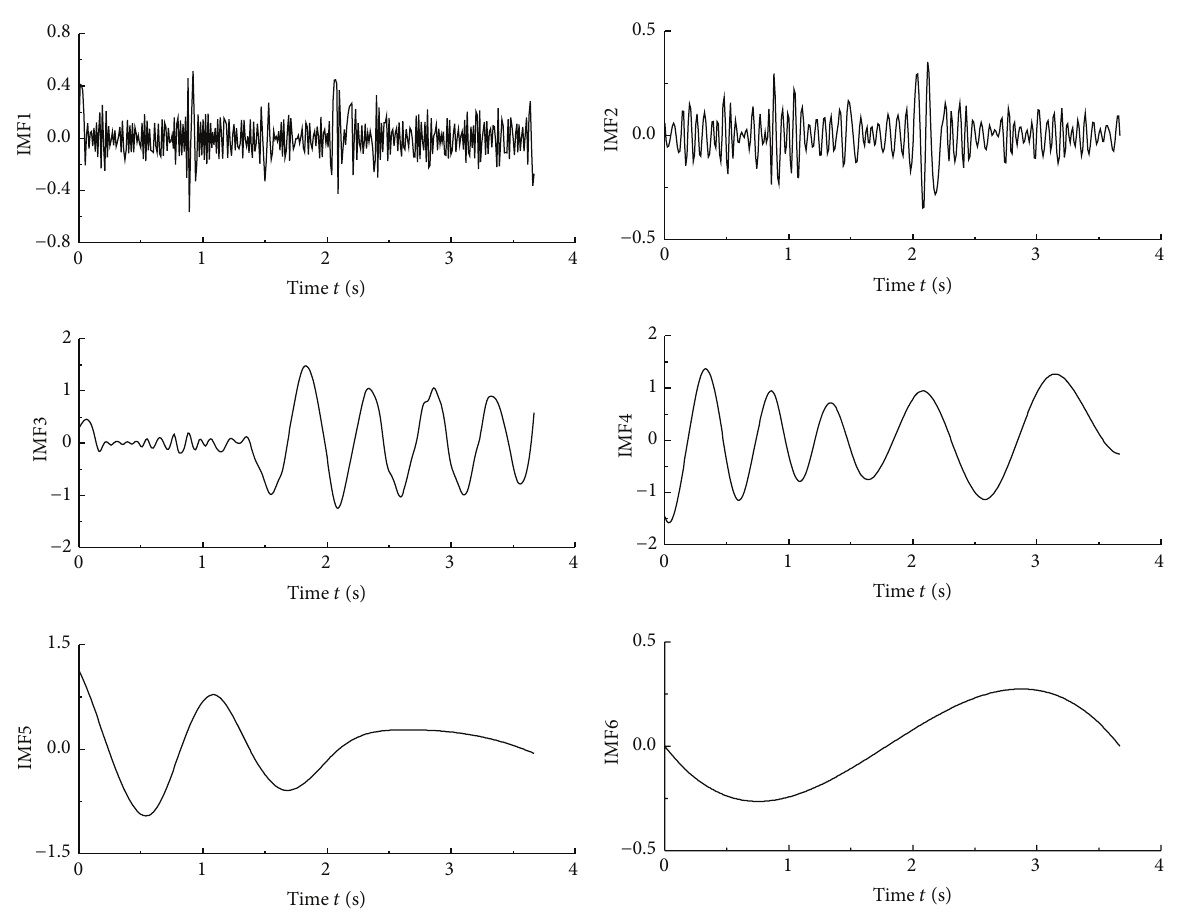
Figure 8: EEMD analysis results of the simulated signal 𝑧(𝑡) .